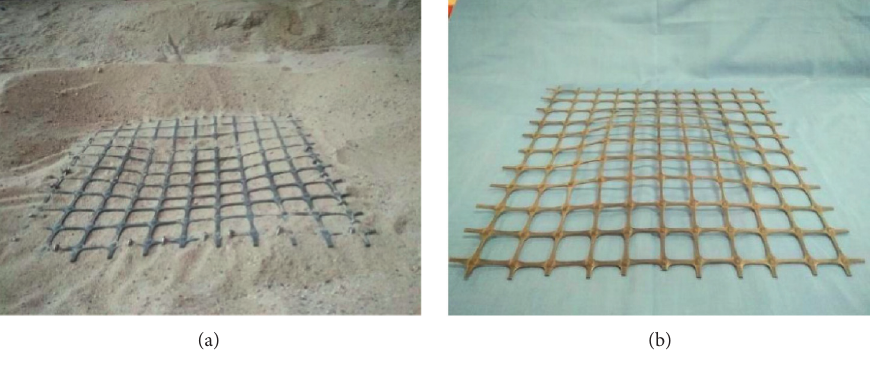
Figure 12: Geogrid-reinforced foundation damage Table 6: BCR of geogrid-reinforced